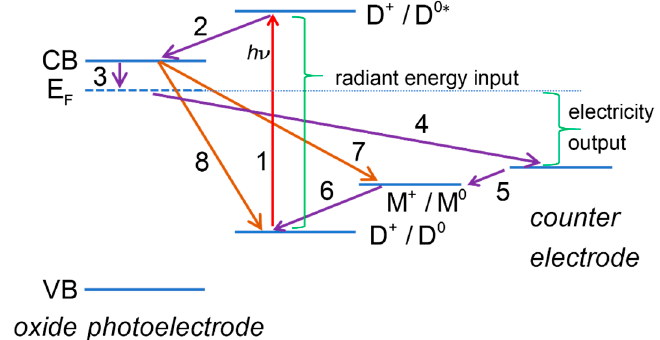
Figure 1. Energy diagram of a dye-sensitized solar cell. Some of the useful processes: (1) dye photoexcitation; (2) electron injection into the mesoporous oxide semiconductor conduction band; (3) transfer of electrons from mesoporous oxide to transparent conducting oxide support; (4) transfer of electrons to the counter electrode (CE) through the external circuit; (5) electron transfer at the CE; (6) dye regeneration. Some of the deleterious processes: (7) recombination of mesoporous oxide electrons with redox mediator; (8) recombination of mesoporous oxide electrons with oxidized dye.